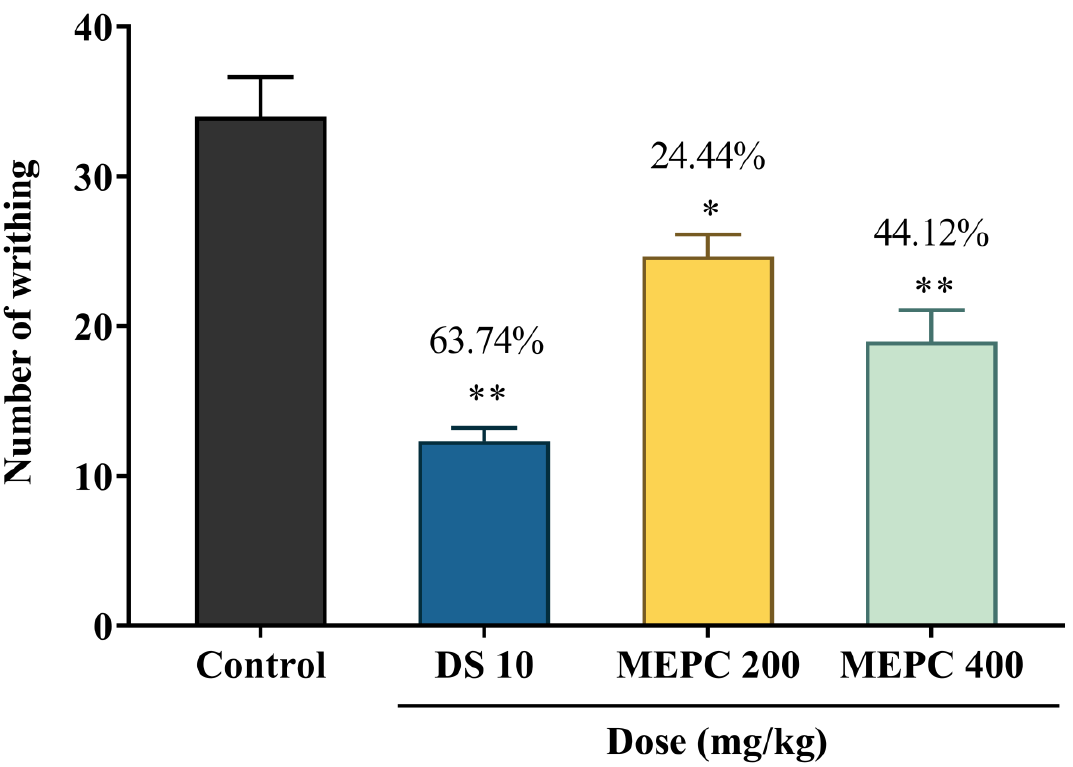
Figure 4. Antinociceptive activity of methanol extract of P. calocarpa (MEPC) and diclofenac sodium (DS) in acetic acid-induced writhing test in mice. Values represented as mean ± SEM ( n = 5). * p < 0.01 and ** p < 0.001 were considered as significantly different from the control (Dunnett’s test).